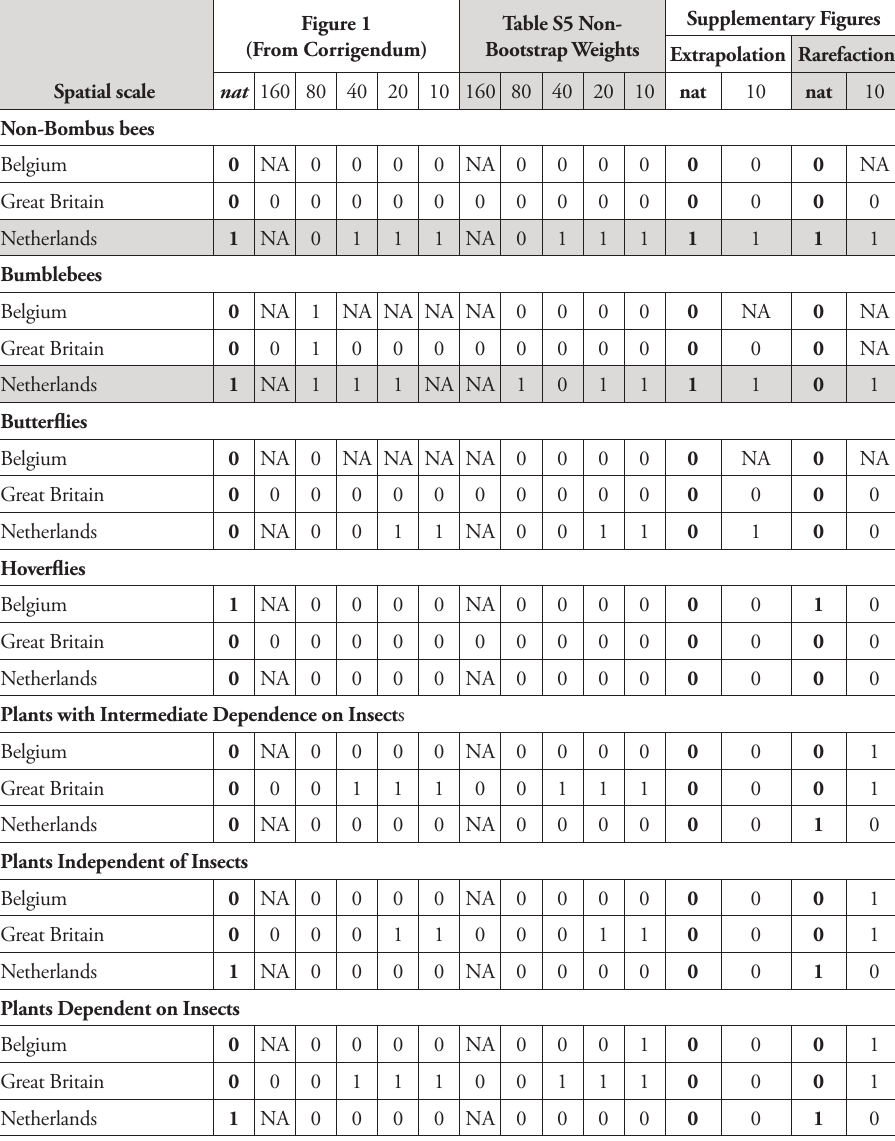
Table 3. A reassessment of results in CA2013. Confidence intervals are extracted and calculated from figures and tables in CA2013. Cells with value “1” indicate taxa and countries where a significant decline in number of species between the two first periods is followed by a change in species number between the two most recent periods, which is significantly less negative (with non-overlapping 95% confidence intervals). Columns “nat” indicate comparisons at the national level and are in bold. I attach a larger im- portance to them as explained in the text. “NA” indicates missing values, where some data were lacking to carry out the comparison. Rows for which I would conclude from CA2013 that there is a decreased decline (provided that further inference problems are ignored) are in